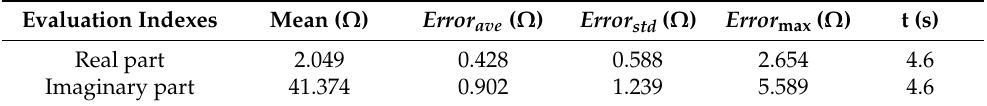
Table 11. Evaluation indexes of method 4 in 7th